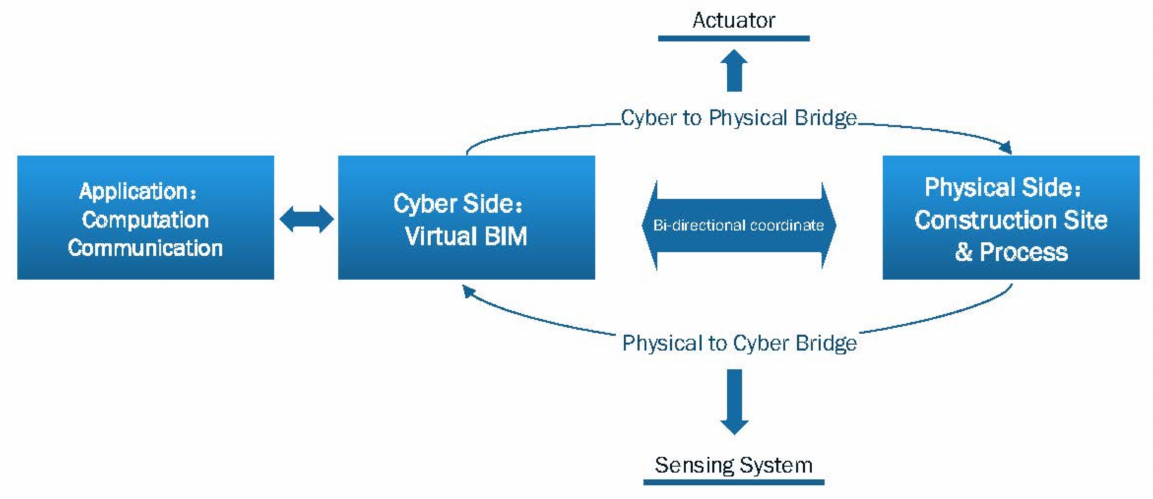
Figure 2. Architecture of